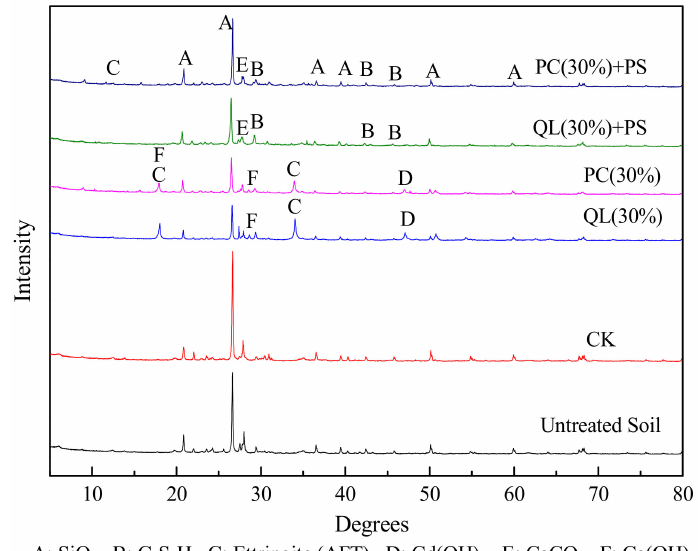
Figure 7. X-ray diffraction patterns of an untreated sample and solidified matrixes after seven days of curing. No amendments added (CK), Persulfate (PS), Quick lime (QL), Portland cement